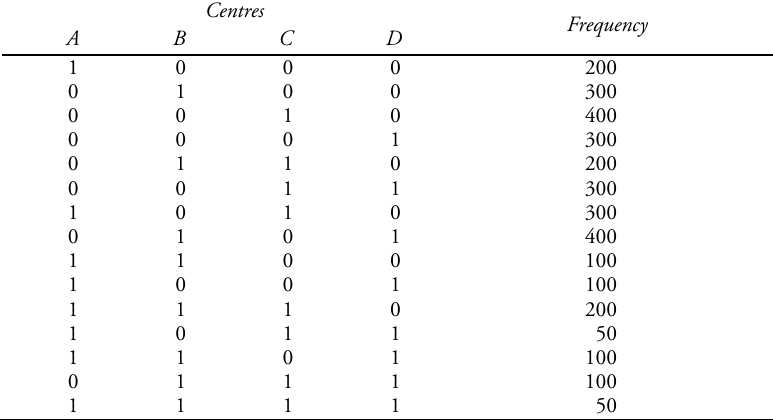
Population distributed by centres of aggregation